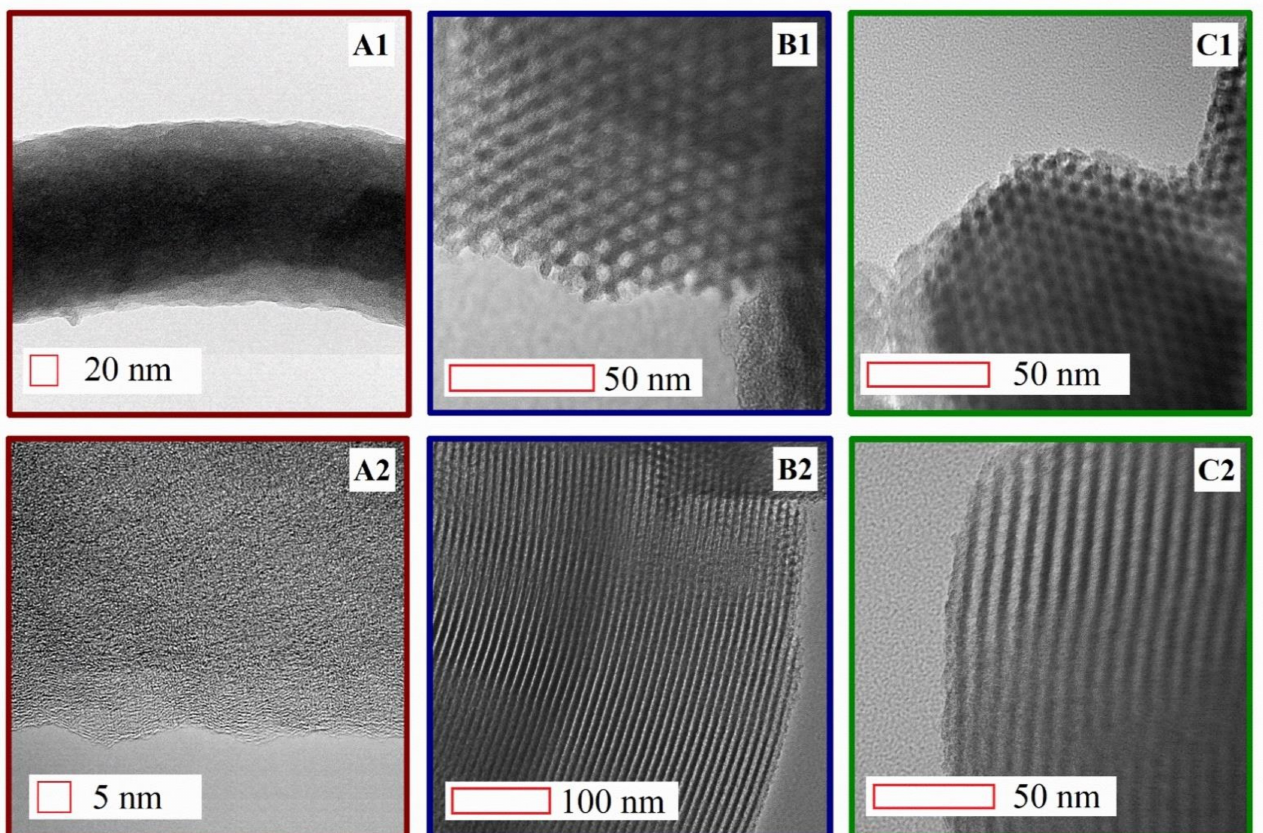
Figure 2. TEM images of ( A ) carbon microfibes, ( B ) SBA-15, and ( C )